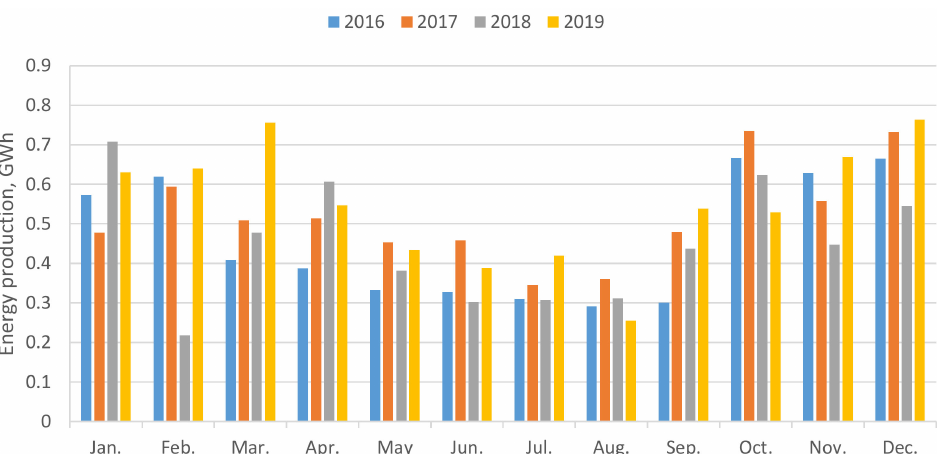
Figure 7. Monthly energy production for the wind farm in 2016–2019.